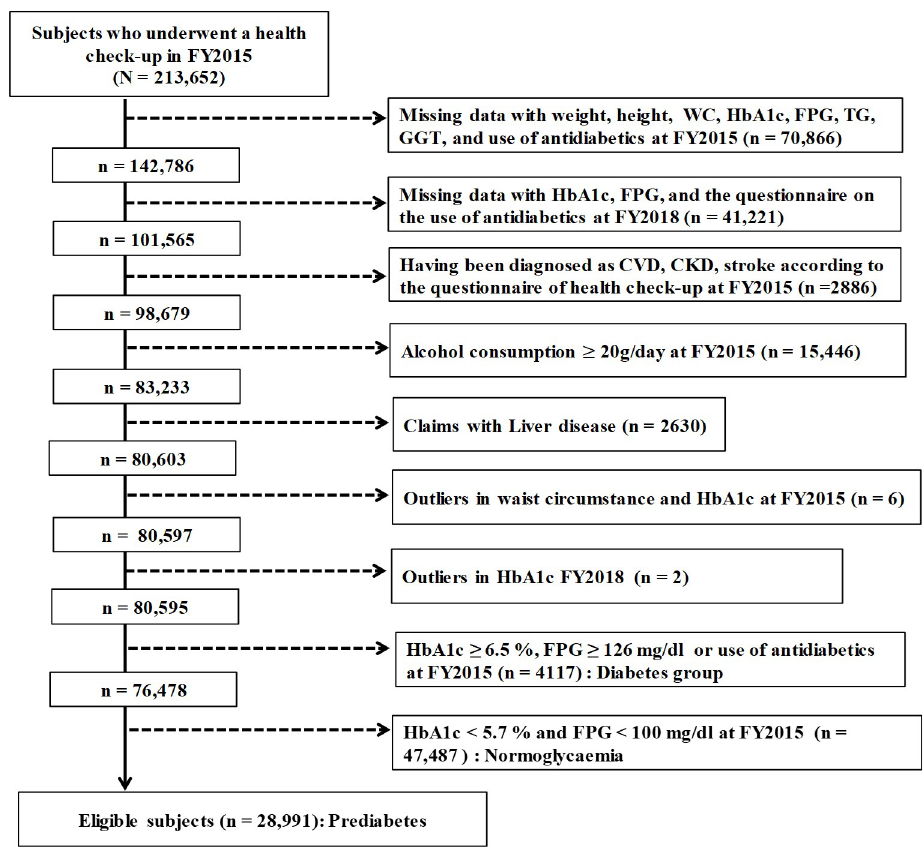
Fig 1. Flow of eligible subjects.